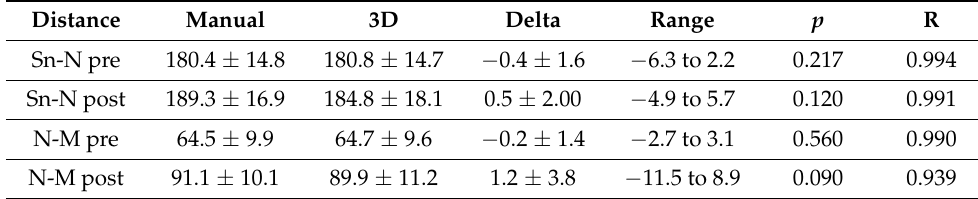
Table 1. Comparison of digital and manual breast distances.